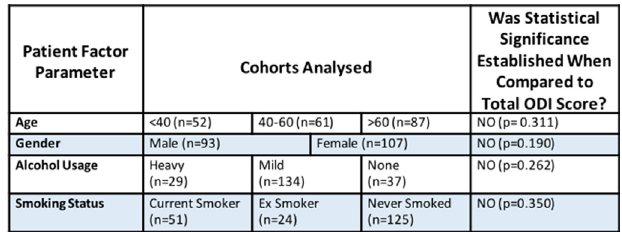
Table 2. Summary of the results of the impact of the other measured patient factors on ODI within Cohort